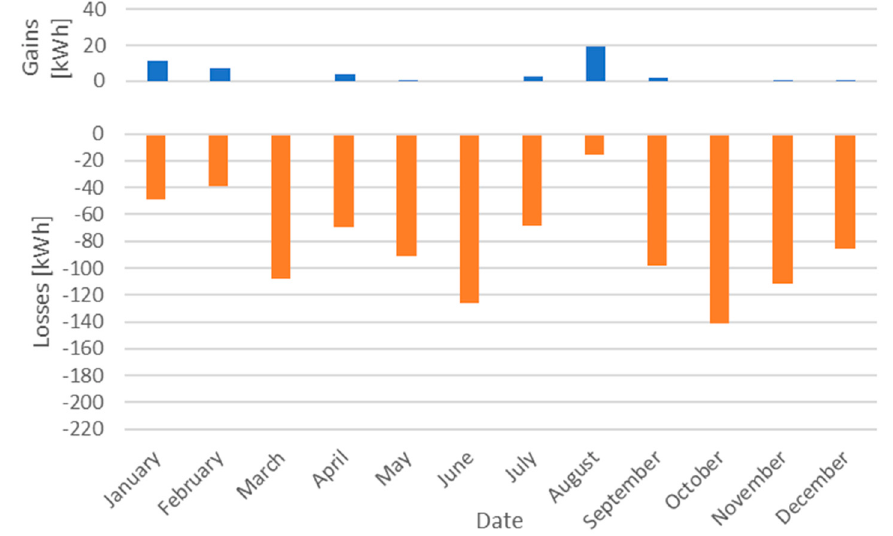
Figure 13. Monthly sum of energy flow between the floor and the ground in variant 1 (wooden floor, no heating).